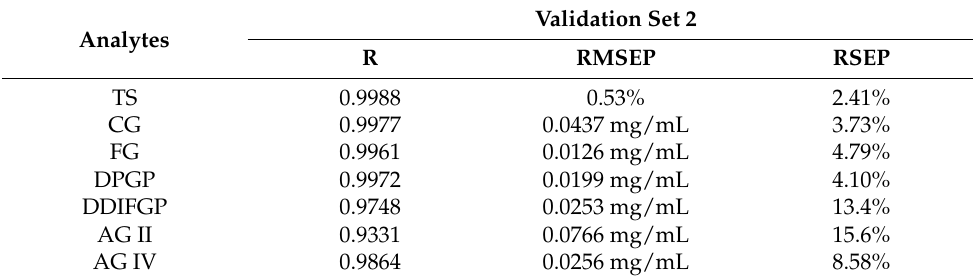
Table 5. Chemometric validation parameters for the 7 quantitative models.